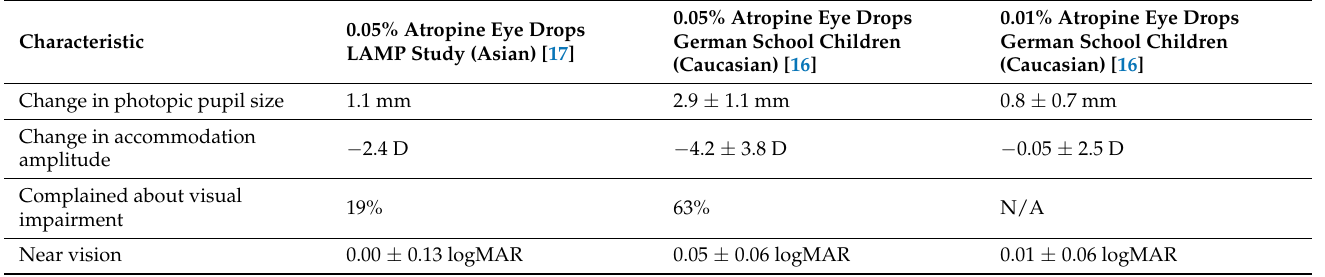
Table 6. Side effects of 0.01% and 0.05% atropine eye